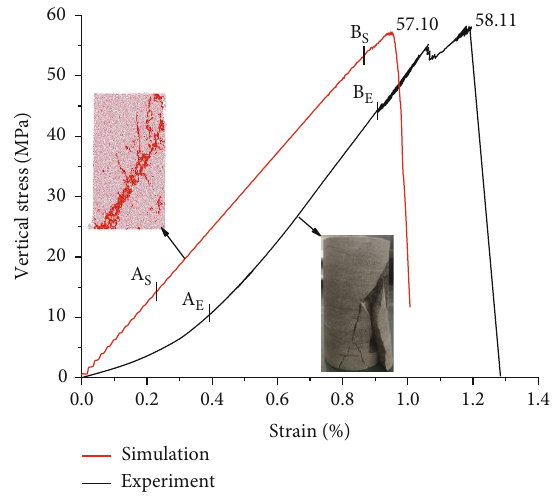
Figure 4: Stress – strain curves of rock obtained from experiments and